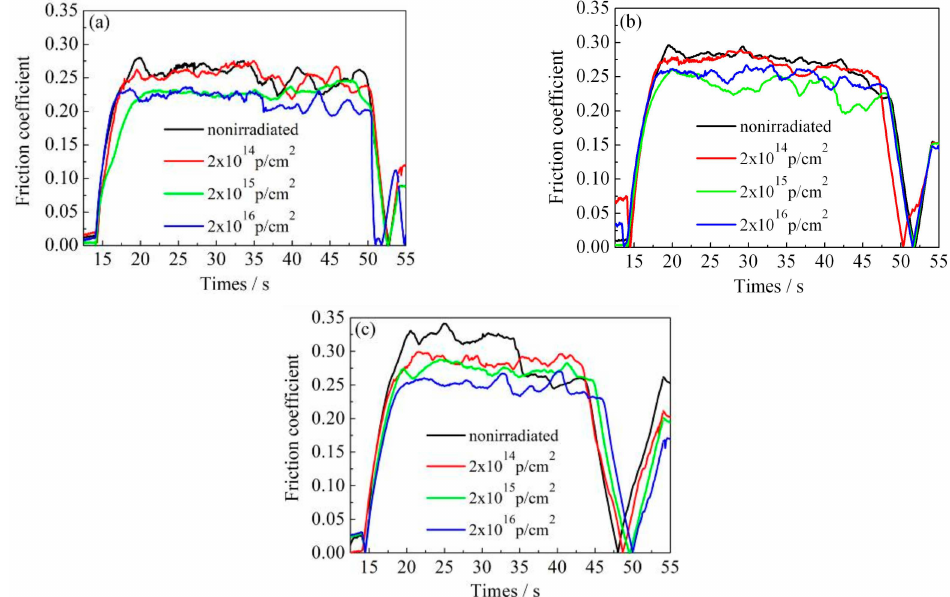
Figure 7. Friction coe ffi cient variations of annealed AISI 420 steels after proton radiation with di ff erent